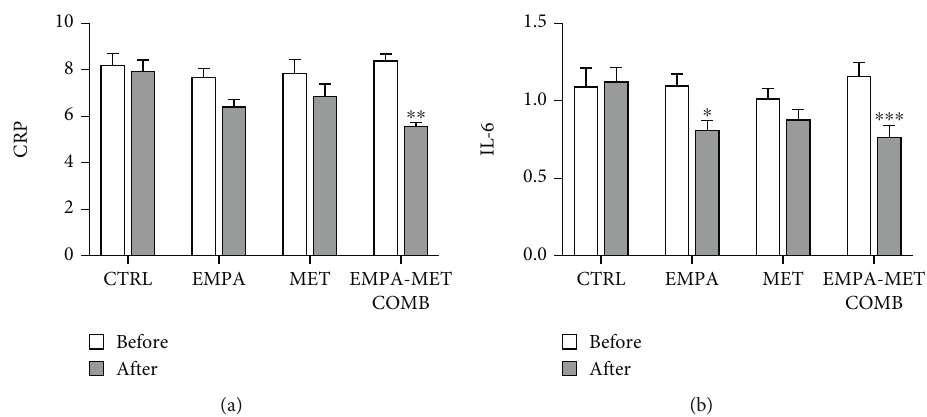
Figure 3: Levels of proin fl ammatory parameters in individuals with type 1 diabetes, before and after treatment with empagli fl ozin 25 mg daily (EMPA), metformin 2000mg daily (MET), empagli fl ozin-metformin combination (EMPA-MET COMB), or in control (CTRL) groups: (a) C-reactive protein (CRP) and (b) interleukin-6 (IL-6). ∗ represents P < 0 : 05 ; ∗∗ represents P < 0 : 01 , and ∗∗∗ represents P < 0 : 001